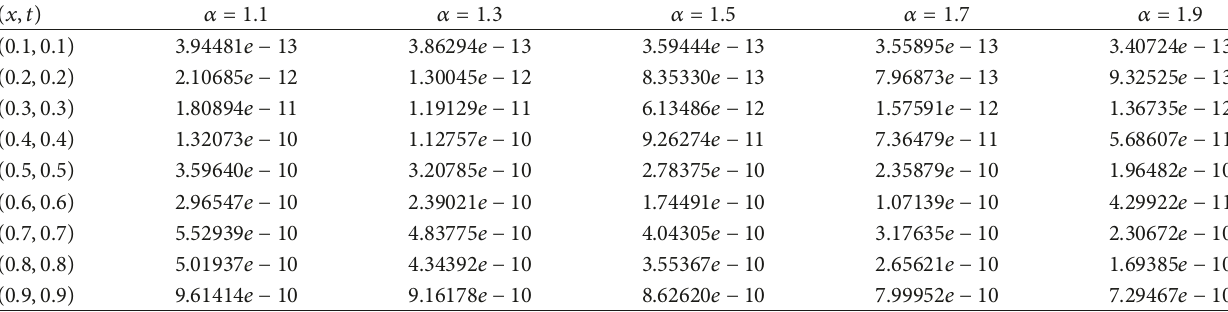
Table 3: The absolute errors for Example 2 for some different values 1 < 𝛼 ≤ 2 at some different